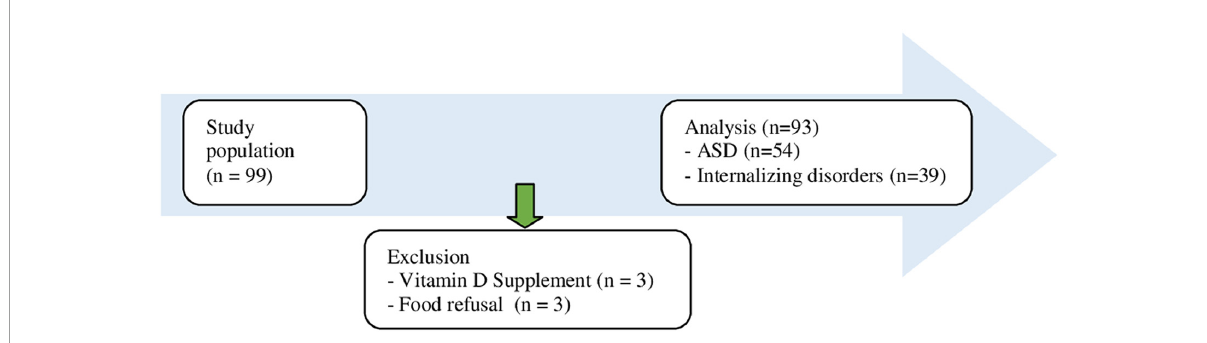
FIGURE1 Flowchart of study inclusion.